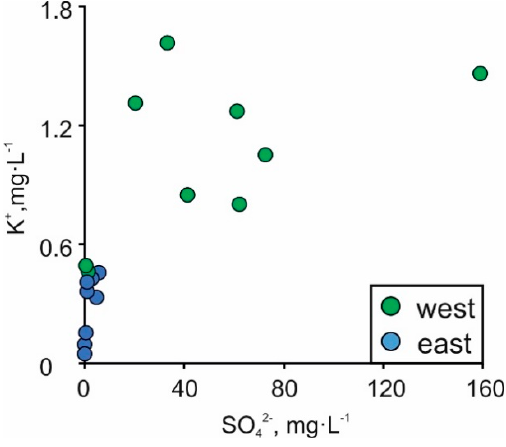
Figure 11. K + and SO 42 − variations in streams.